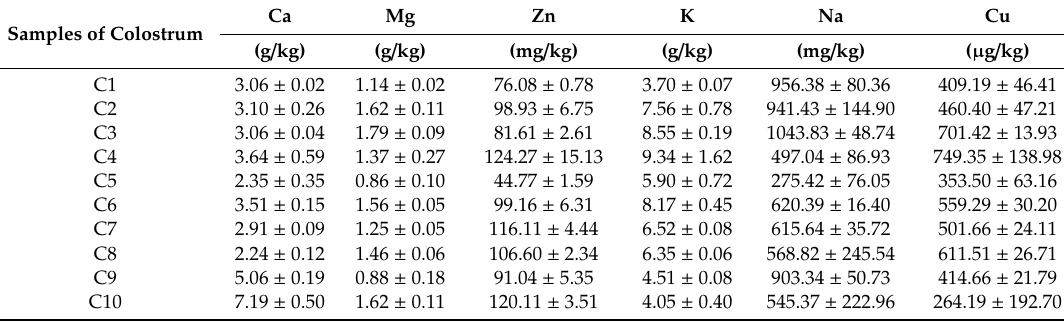
Table 3. Mineral composition of bovine colostrum samples (C1–10).